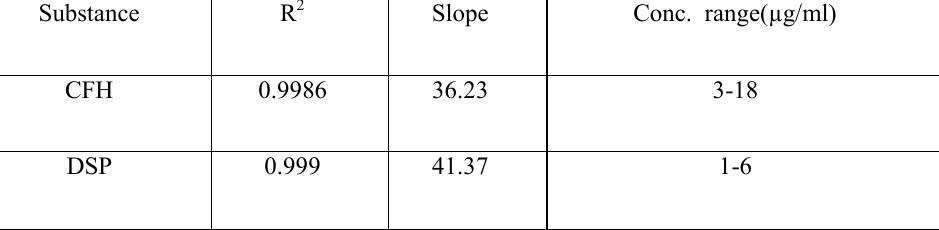
Table 1. Linearity by regression analysis